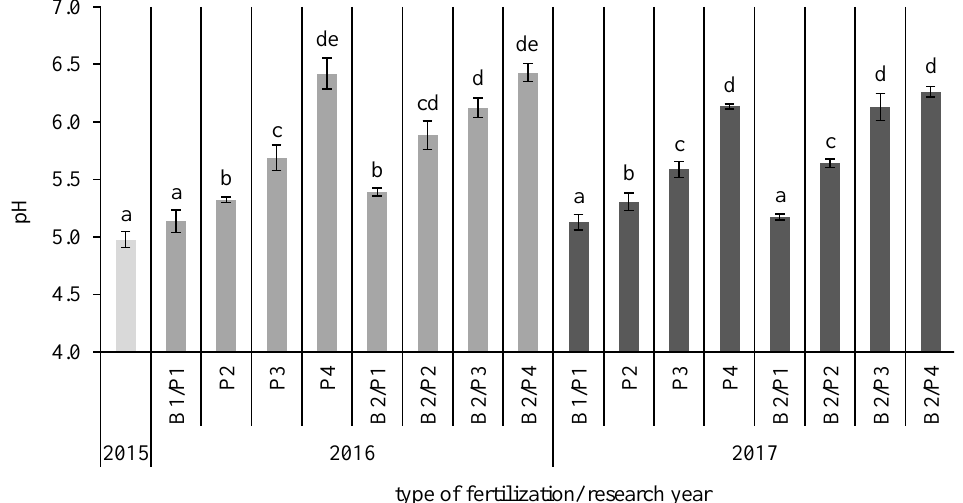
Figure 1. pH value of the soil before the experiment (2015) and after the first and second year of cultivation, depending on the fertiliser used. Differences between average values marked with the same Arabic letters are not statistically significant at the level of α ≤ 0.05 according to the Bonferroni test.